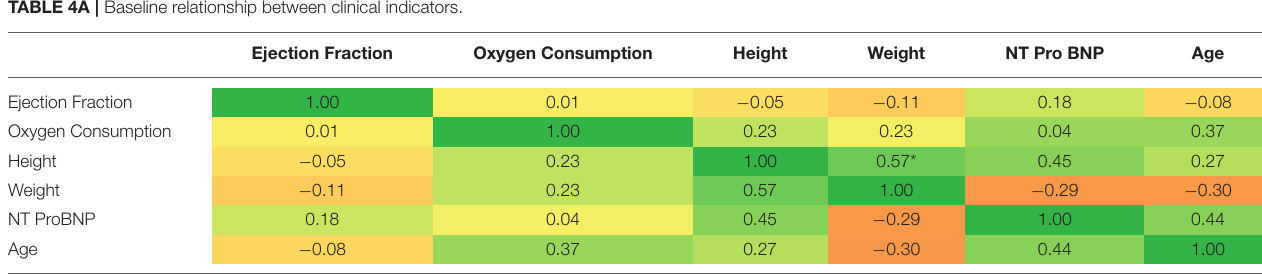
TABLE 4A | Baseline relationship between clinical indicators.